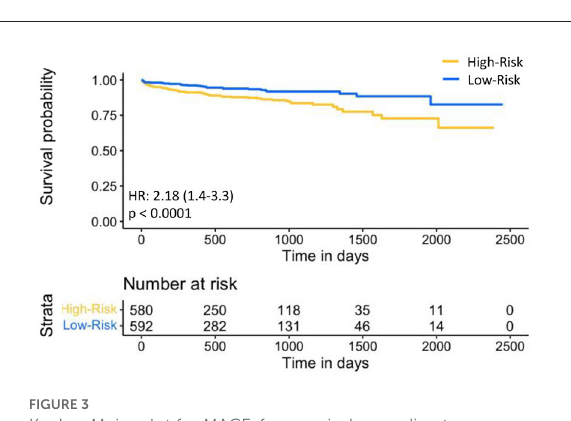
FIGURE3 Kaplan-Meier plot for MACE-free survival according to eRiS-based risk groups in S v . The eRiS threshold of − 0.055 showed two distinct groups of high vs. low MACE-free survival in S v